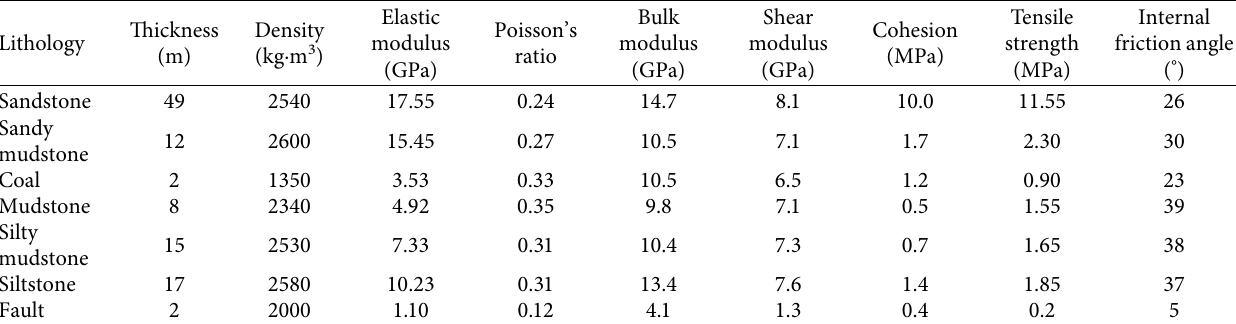
Table 1: Rock mechanics parameters of 1503 working face in Xinchun coal mine.